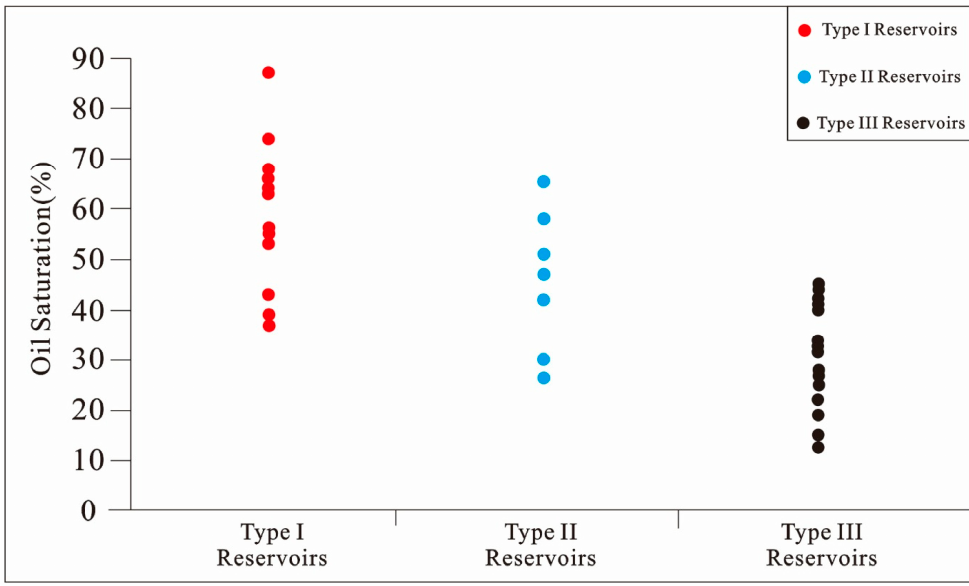
Figure 11. The oil saturation characteristics of different